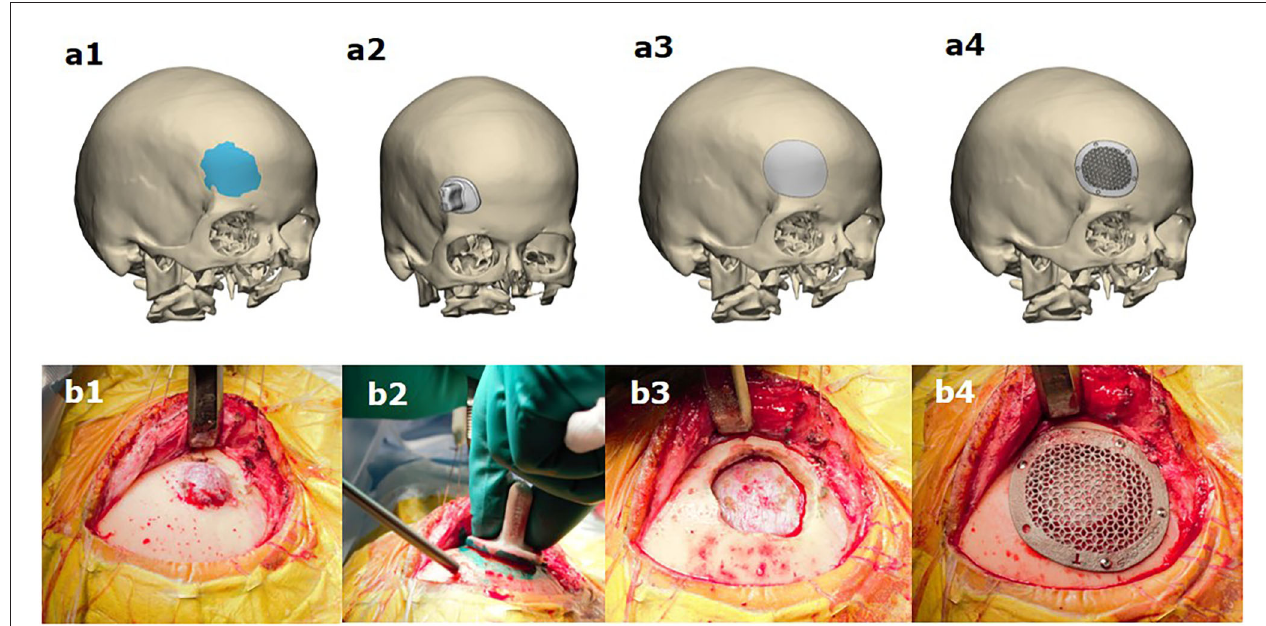
FIGURE 2 | Simultaneous resection of bone tumor and titanium cranioplasty in patients with a lesion in the fronto-orbital region (b1–b4) according to pre-operative virtual planning of resection margins (a1) , using a drilling template (a2) and the simultaneous fabrication of the cranioplasty (a3,a4)